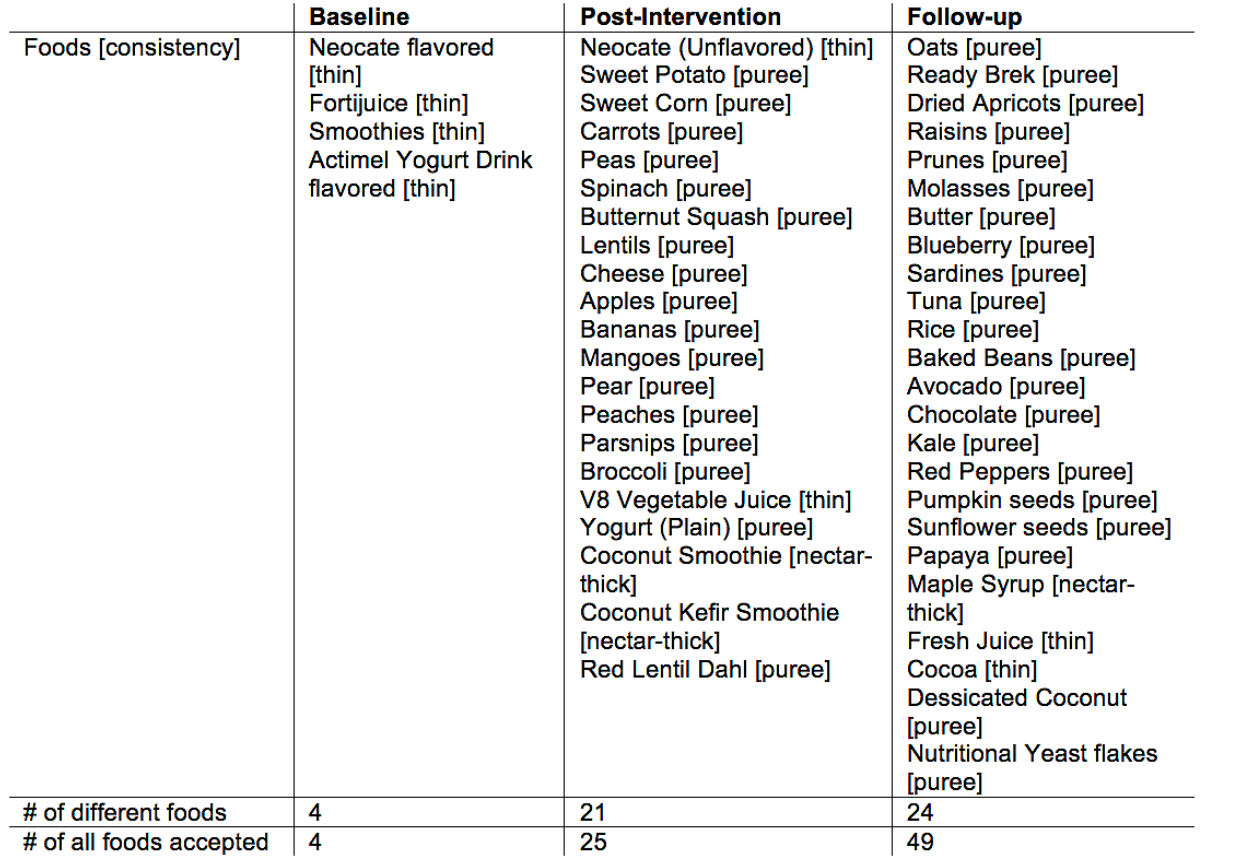
Table 3. Acceptance of Foods and Consistencies (Different Foods Accepted at Three Time